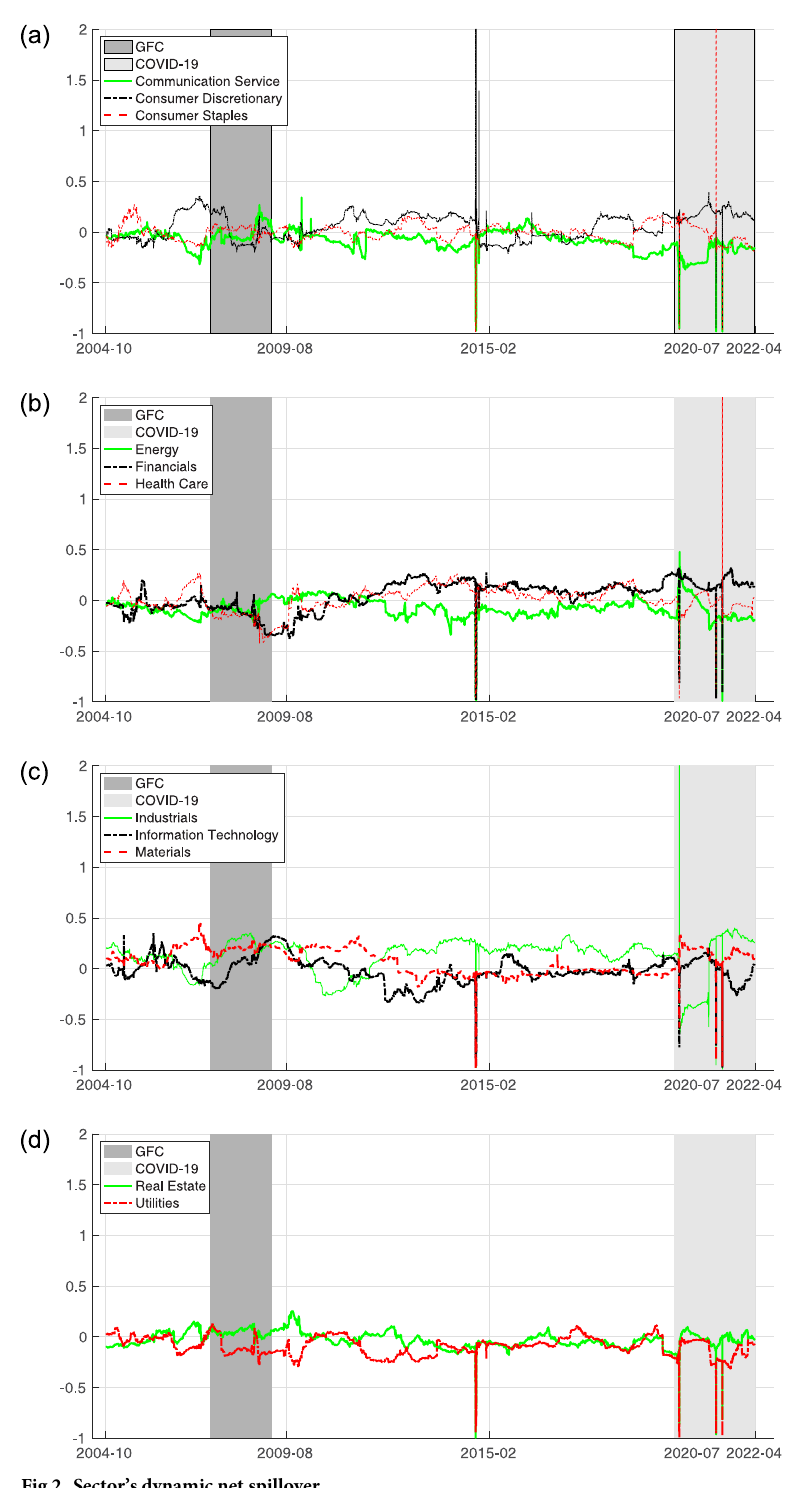
Fig 2. Sector’s dynamic net